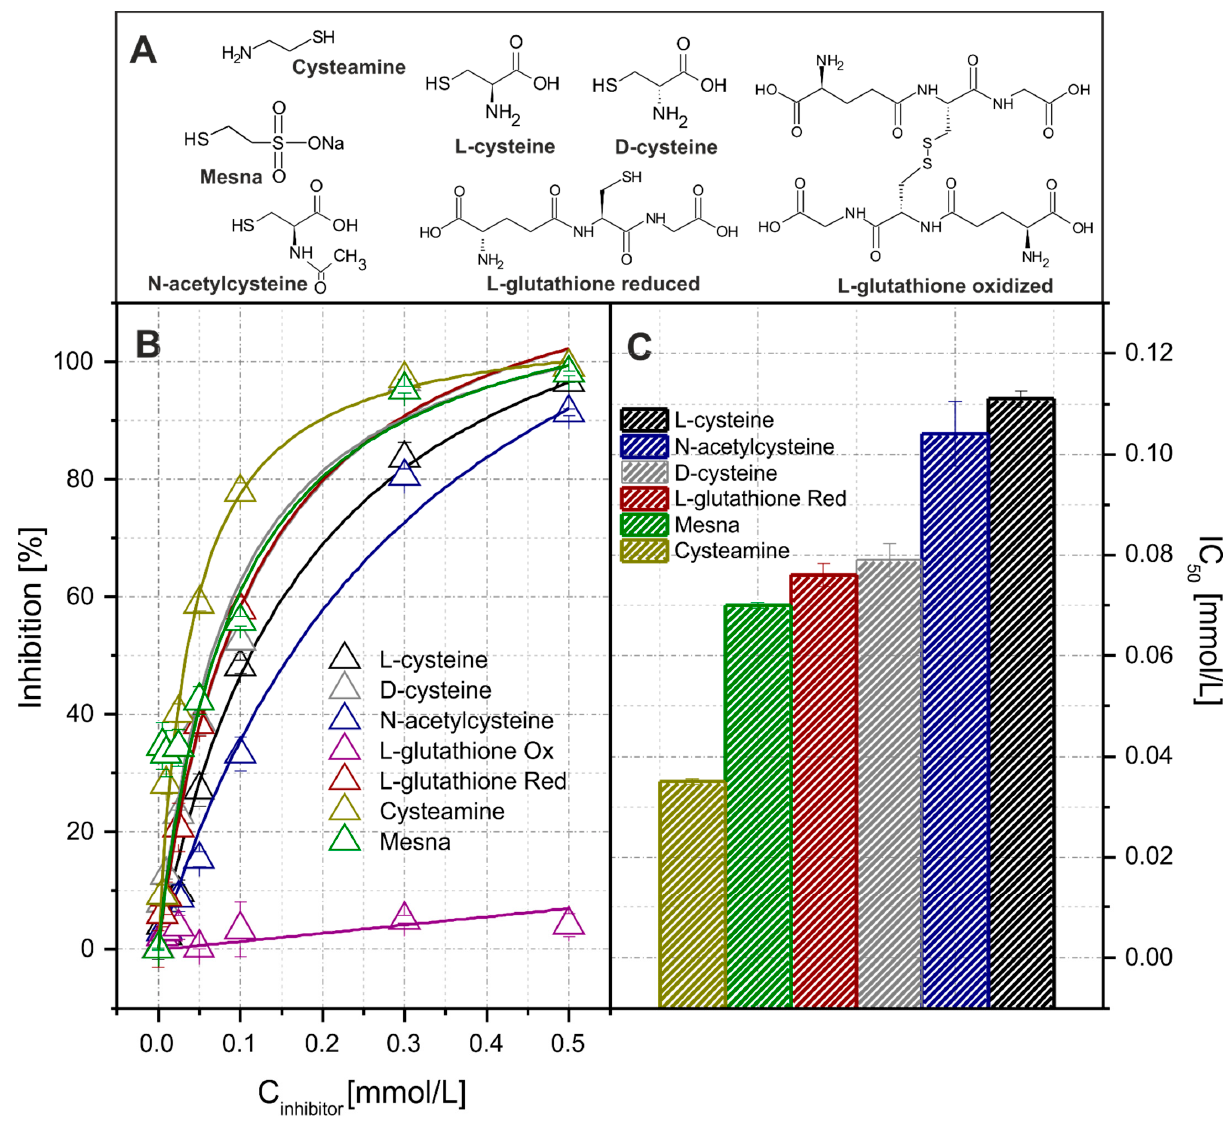
Figure 5. The structures of the selected thiols ( A ). The dependences between the reaction inhibition percentage and inhibitor concentration ( B ). The individual curves for each inhibitor are shown in Figure S4 in the Supplementary Materials. The column plot showing the IC 50 (half maximal inhibitory concentration) of the particular thiols on HRP activity ( C ). The bar for the oxidized glutathione is not shown due to the lack of inhibitive activity. Error bars represent one standard deviation for n = 3.